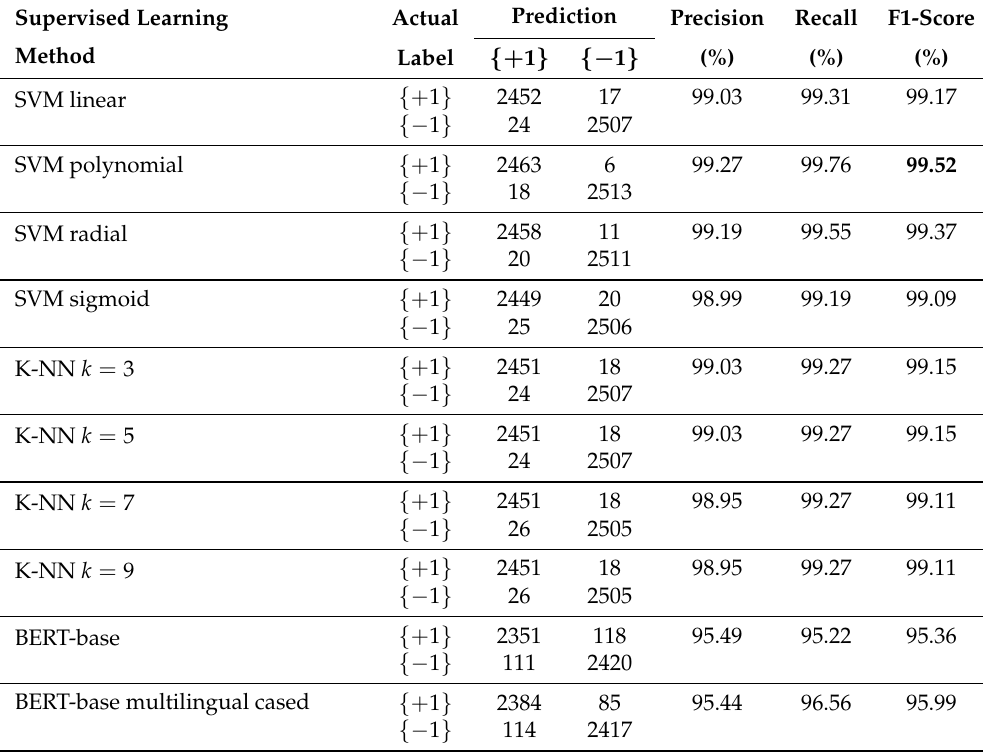
Table 2. Evaluation results for the training models in the ten-fold cross-validation